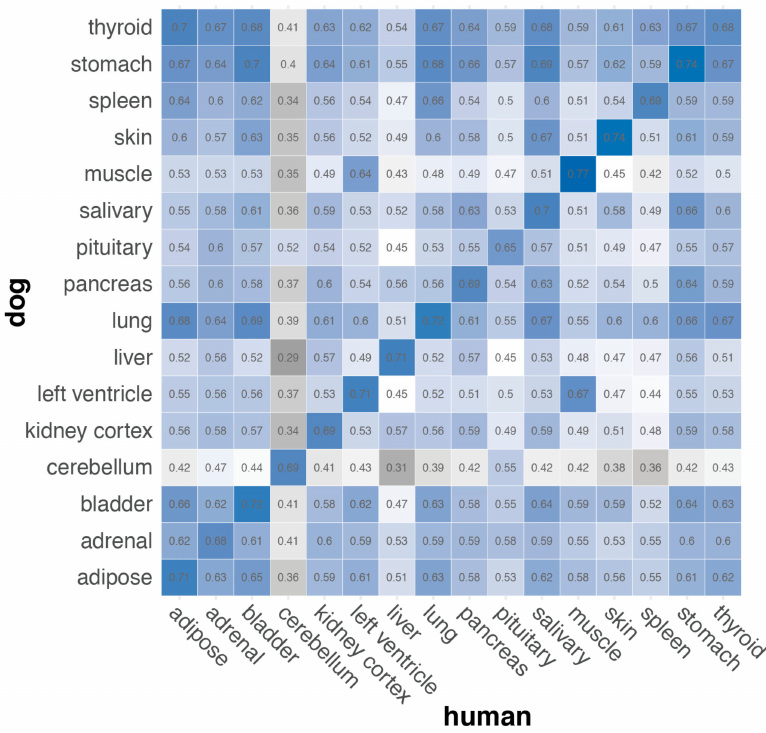
Figure 7. Gene expression levels correlate between dog and human tissues. Heatmap showing Spearman correlation between the genes expressed in canine and human tissues, after filtering for minimum expression (median CPM > 1) and unique orthology mapping between species. In all cases except one (dog thyroid), comparison of dog tissue to the corresponding human tissue had the highest Spearman coe ffi cient, suggesting broad conservation of the transcriptome in these tissues across